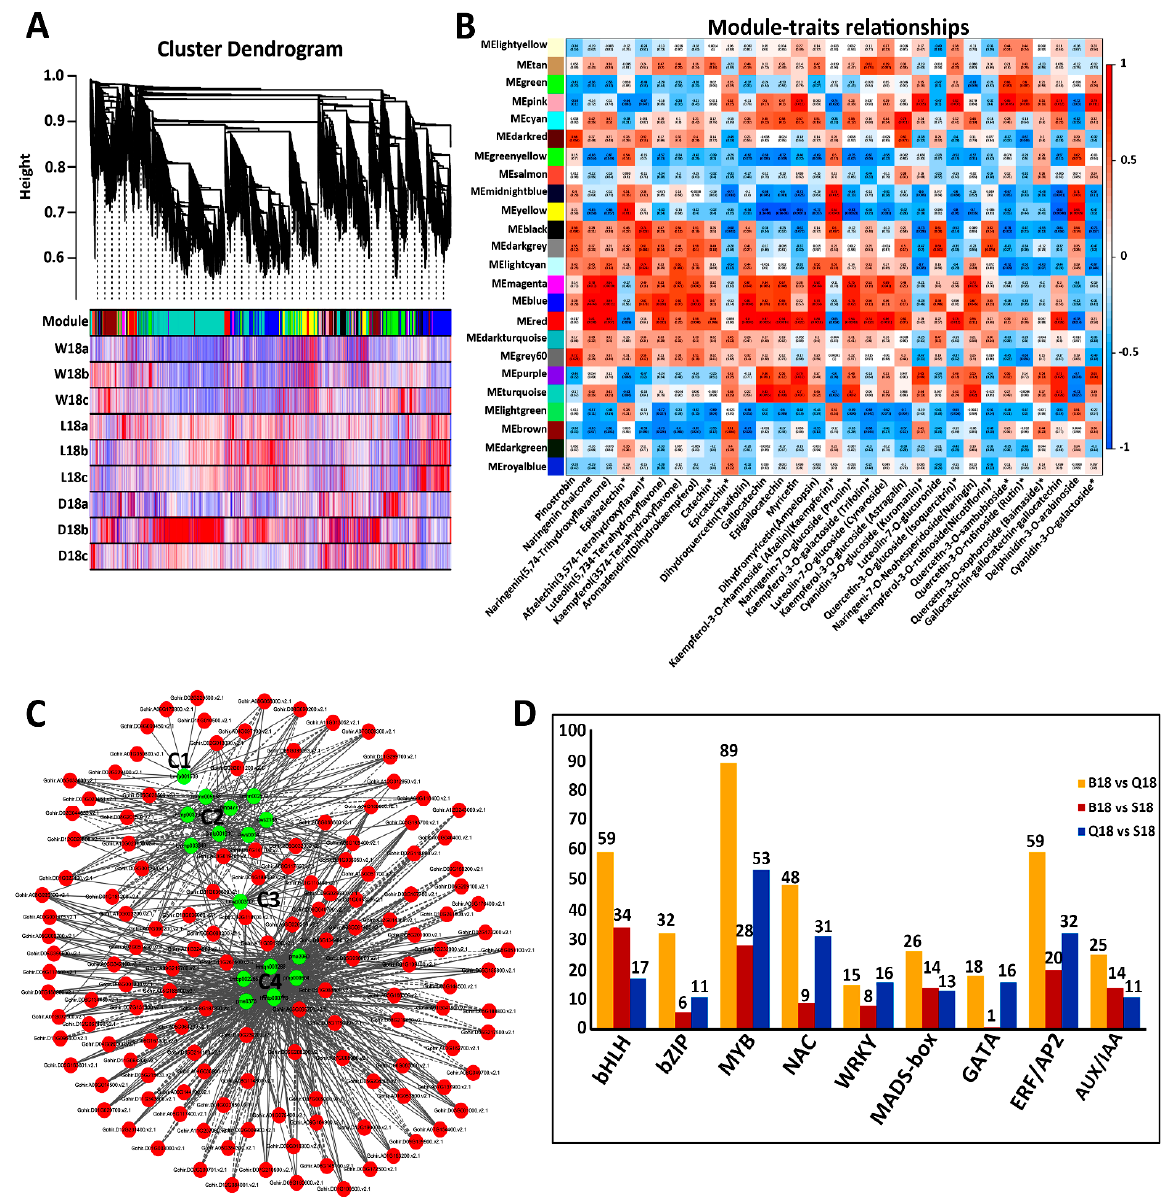
Figure 6. WGCNA of differential gene expressions and the related traits. ( A ) Hierarchical clustering dendrogram tree showing co-expression modules. Similar color-coded modules represent genes with similar expression patterns. ( B ) Module–trait relationship. The cells were assigned colors based on their statistical significance, labeled with two numbers; the lower number indicates the p -value and the upper number indicates the correlation coefficient. (*) denotes differentially expressed metabolites. ( C ) Correlation analysis between metabolites and genes. Metabolites are shown in green, and genes are shown in red, with solid lines representing positive correlations and dashed lines representing negative correlations. ( D ) The number of differentially expressed transcription